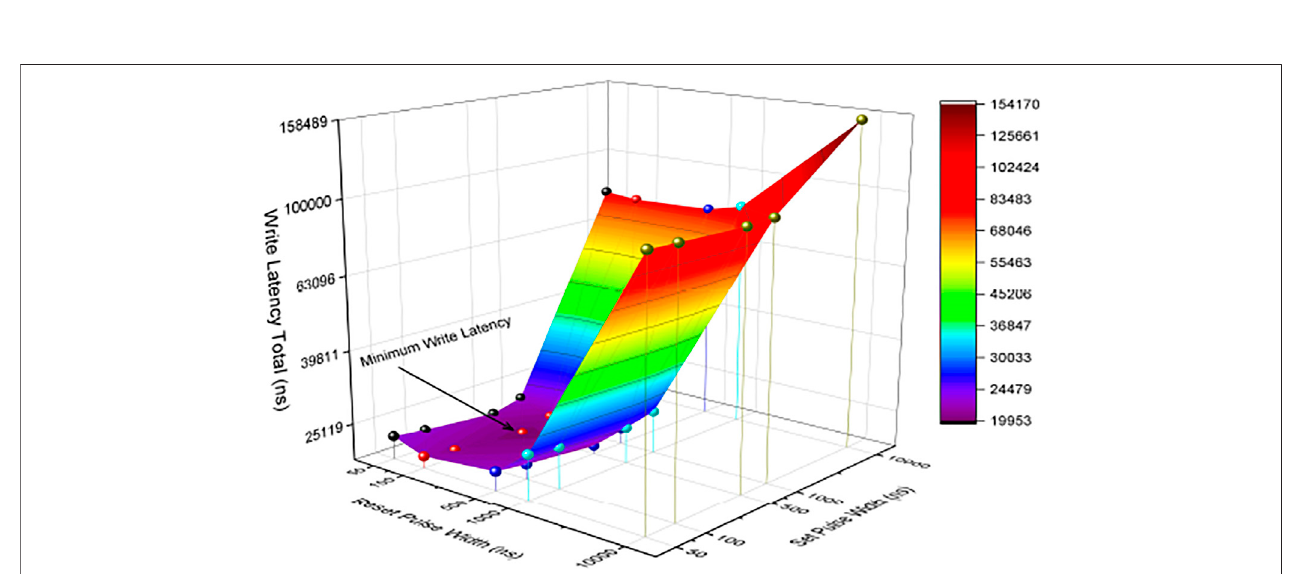
FIGURE 13 | Write latency over different pulse widths.